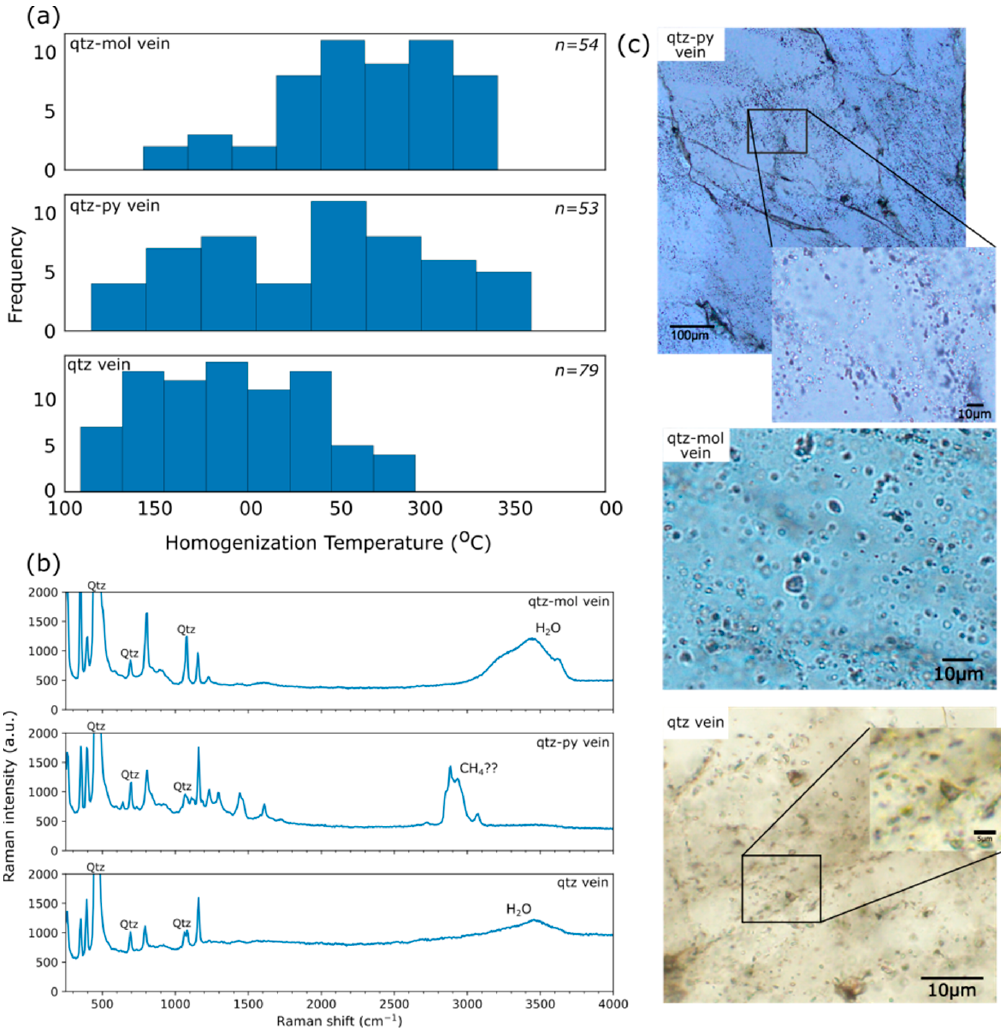
Figure 9. ( a , b ). Homogenization temperatures and fluid compositions of stage 1–3 veins. ( c ) Photomicrograph of representative fluid inclusions (plane-polarized light).